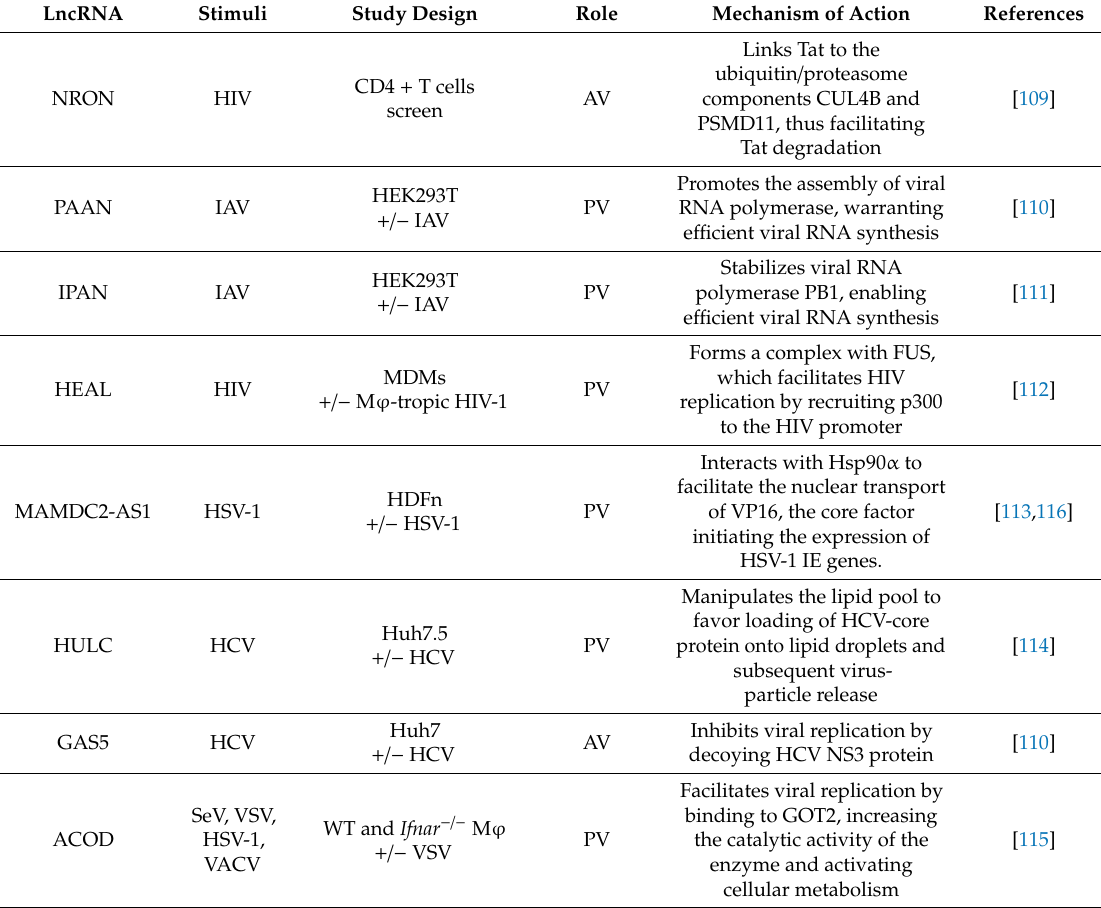
Table 1. LncRNAs deregulated by viral infections unrelated to the antiviral